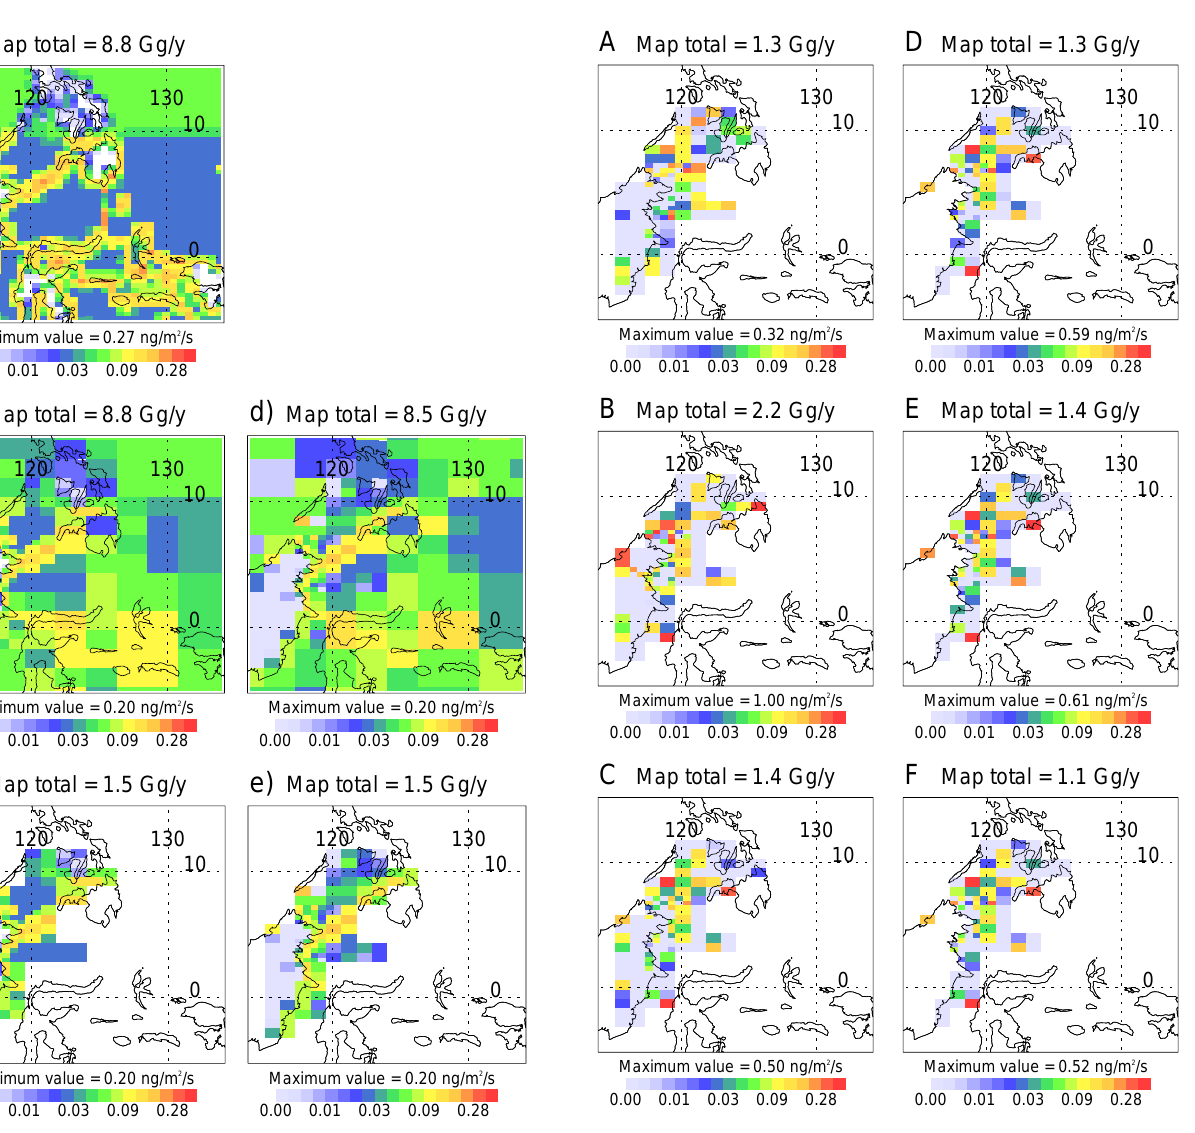
Fig. 6. Estimated emissions of CHBr 3 , for the “fine” grid cells (shades of red in Fig. 3). Experiment labels (see Table 2) are to the top-left of the plots, and in each case the mean of 25 sepa- rate solutions to the inversion process is shown. The total emission from the “fine” solution grid cells is noted above the plot (units are GgCHBr 3 yr − 1 ), and the colour scale is